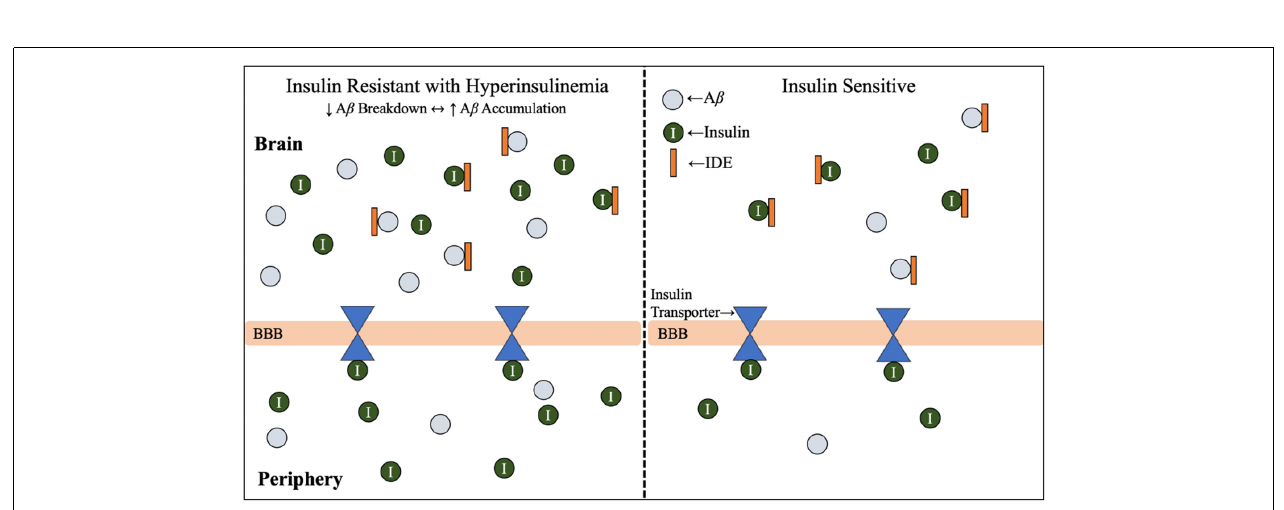
FIGURE 3 | Insulin resistance and hyperinsulinemia increases competition for IDE. Mechanism by which T2D conditions of insulin resistance and hyperinsulinemia contribute to increased competition for IDE, and therefore increased accumulation of A β . As introduced in Figure 2 , IDE is responsible for the degradation of excess insulin and A β in the brain. Hyperglycemia, hyperinsulinemia, and insulin resistance are symptoms of T2D, and the combined effect of hyperinsulinemia and A β accumulation leads to increased competition for IDE, resulting in accumulation of both A β and insulin in the brain. Abbreviations: A β , amyloid beta; AD, Alzheimer’s disease; IDE, insulin degrading enzyme; T2D, type 2 diabetes; BBB, blood-brain